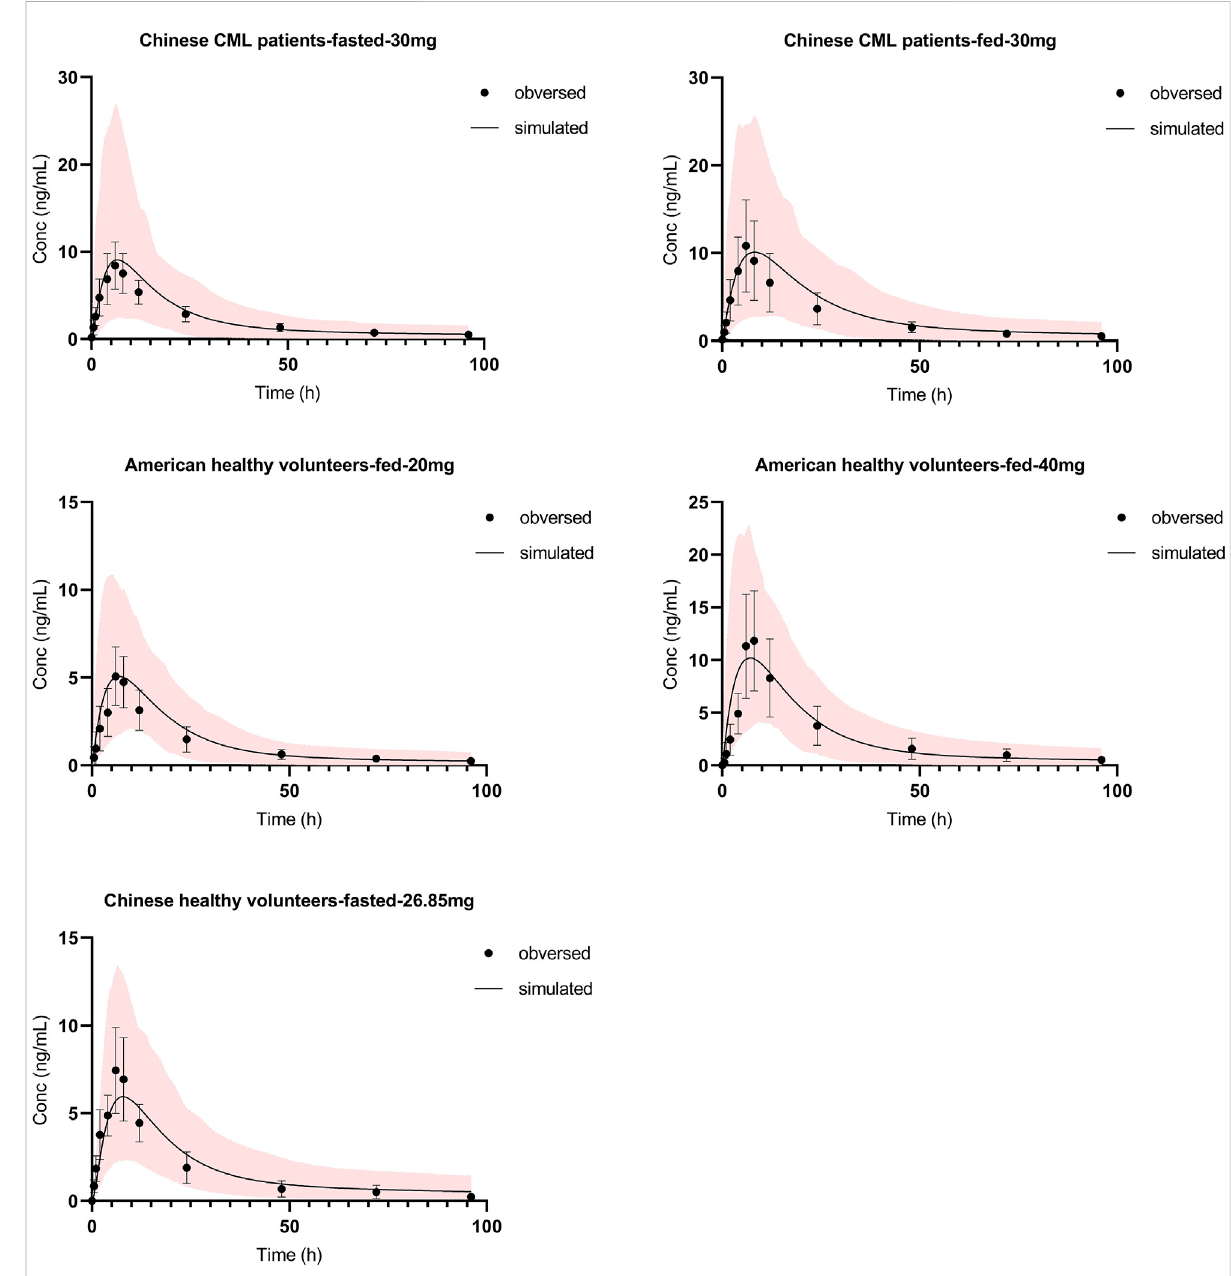
FIGURE 2 Olverembatinib PBPK model veri fi cation. Observed (mean and standard deviation, dots and bar) and simulated (solid lines) mean plasma concentration-time pro fi les of olverembatinib in different populations following single oral doses of olverembatinib (30, 20, 40 or 26.85 mg). The shaded area is the 5 – 95% range in concentrations from 1,000 simulated healthy Chinese or American adult